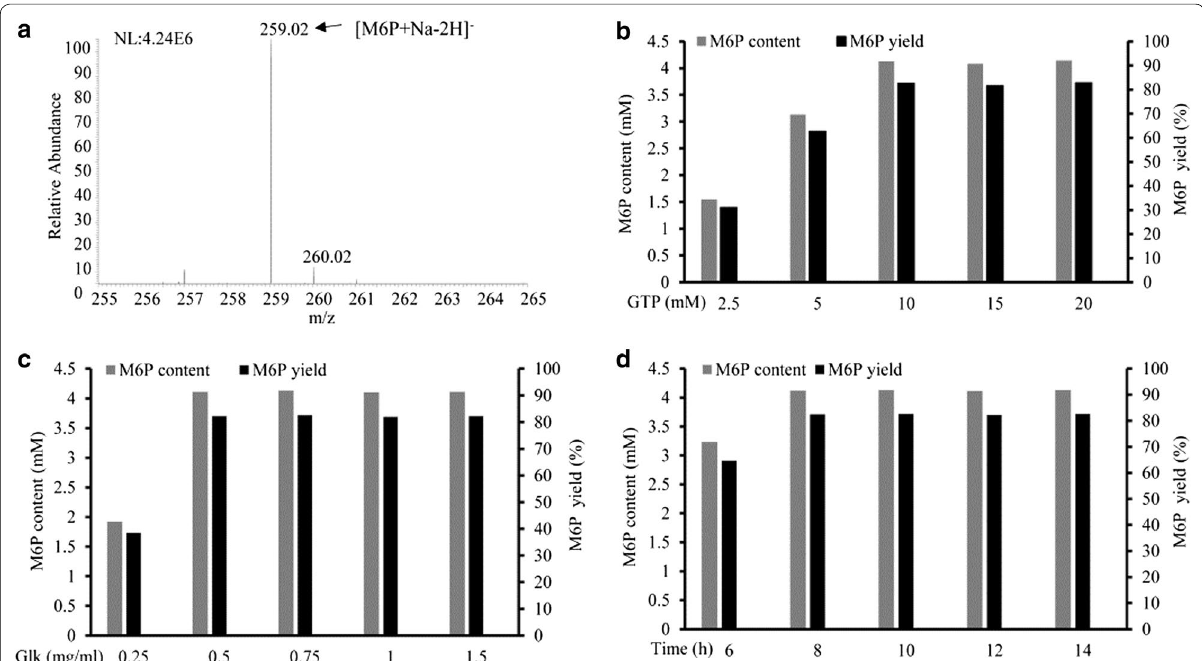
Fig. 3 MS analysis on the production of mannose-6-phosphate (M6P) using GTP as phosphate group donor ( a ). Effects of GTP content ( b ), Glk content ( c ) and conversion time ( d ) on production of